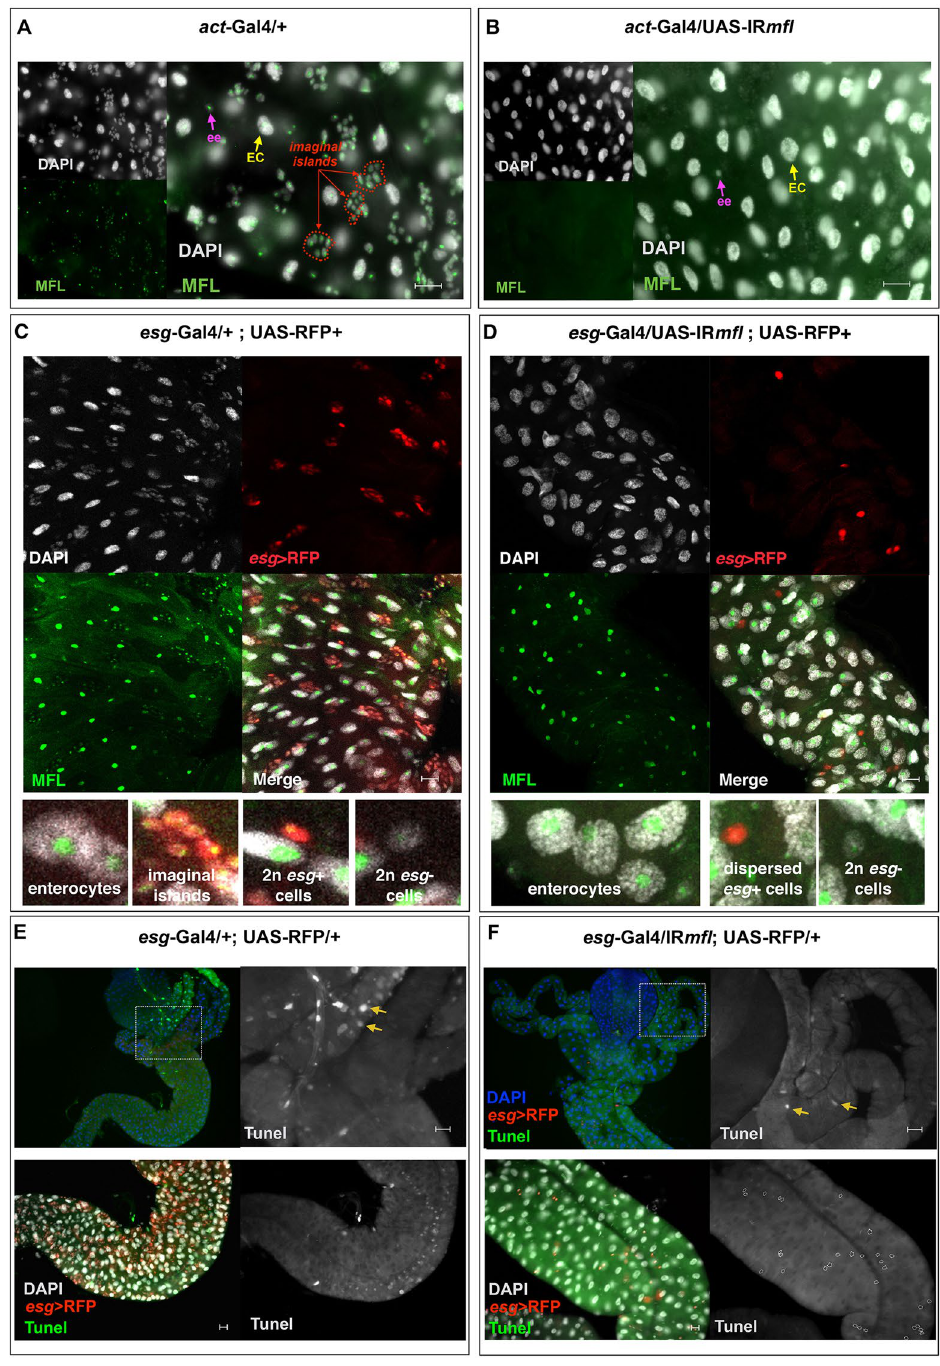
Figure 1. Depletion of Drosophila dyskerin (MFL protein) disrupts the formation of larval midgut stem cell niches. Control ( A , C,E ) and silenced ( B , D , F ) midguts were analyzed in epifluorescence at the third larval stage. DAPI is in grey; anti-MFL antibody in green; esg -expression domain is marked in red by an UAS-RFP reporter line. Scale bars: 20 µ m. Yellow arrows mark enterocytes (ECs); purple arrows enteroendocrine cells (ees,); red arrows stem cell niches (imaginal islands). In ( A ), all nuclei accumulate the MFL protein. In ( B ), ubiquitous gene silencing drastically abolishes MFL accumulation in all cell types, but specifically disrupts only formation of imaginal islands. In ( D ), MFL depletion was restricted to esg + cells and resulted in the same outcome. ( E , F ) TUNEL staining of control ( E ) and silenced ( F ) midguts. DAPI is in green or grey; TUNEL in green or gray; esg -expression domain is marked in red by an UAS-RFP reporter line. Note that in both samples only a very few cells are stained (see yellow arrows); moreover, the rare dispersed esg + cells present in the silenced midgut (encircled in the right inset) remain unstained, indicating that they are not undergoing